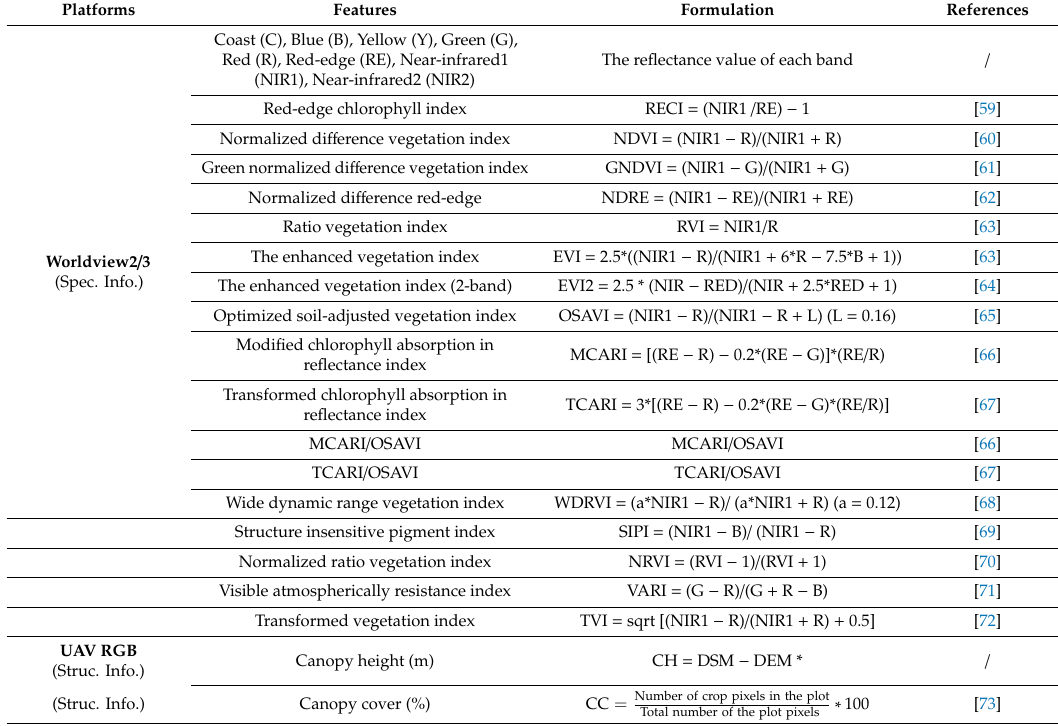
Table 3. Descriptions of spectral and structure features used for AGB, LAI, and N estimation in this